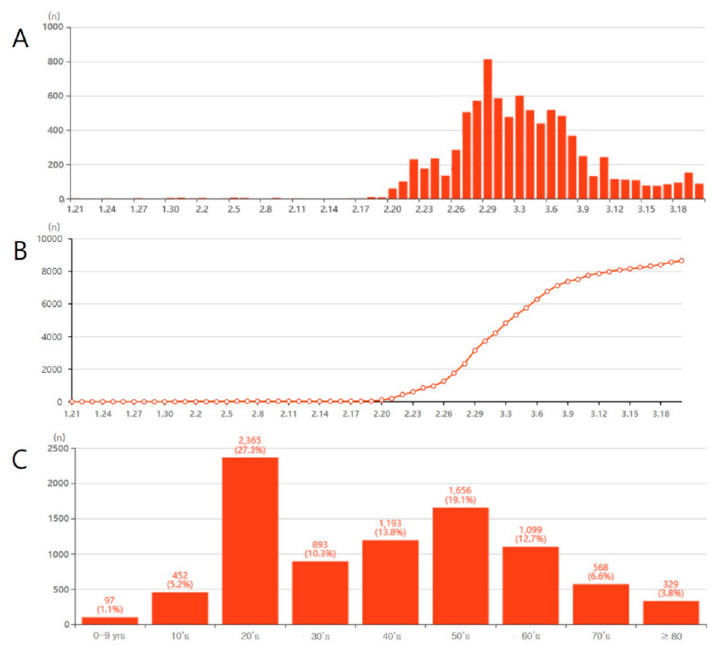
Figure 1. ( A ) Daily number of coronavirus disease (COVID-19) confirmed cases in South Korea, ( B ) daily cumulative number of COVID-19 confirmed cases in South Korea, ( C ) number of COVID-19 confirmed cases according to age range. Source: www.coronaboard.kr.